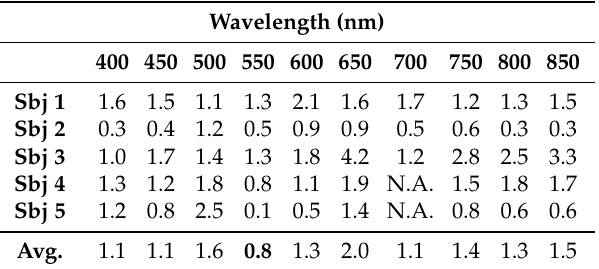
Table 4. High frequency (HF)/low frequency (LF) root–mean–squared error (RMSE) between the SPAD estimation and the ECG ground truth one. Bold values represent best results.